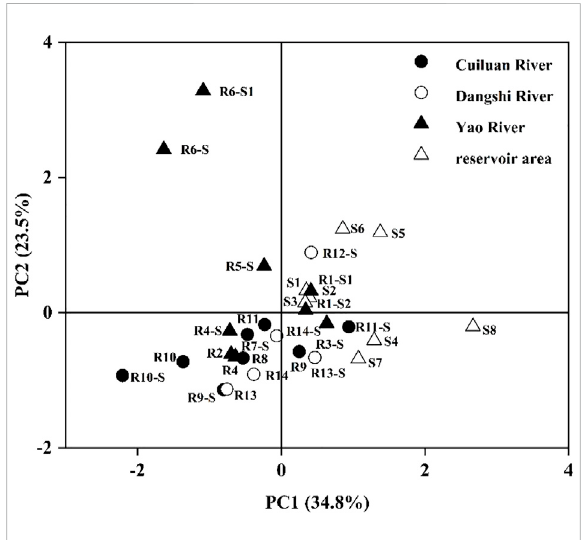
FIGURE 6 Principal component analysis of P fractions in sediments and surrounding soils of the Xishan Reservoir drainage